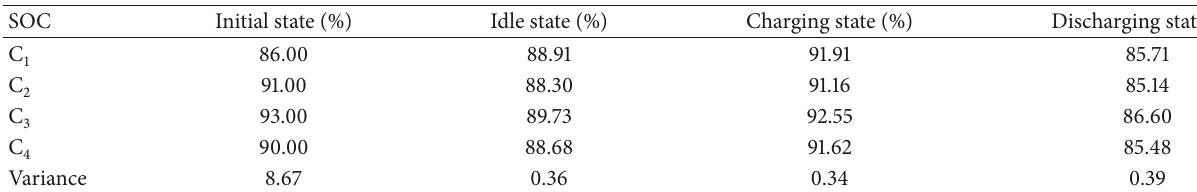
Table 4: Comparison of equalization results in three states.